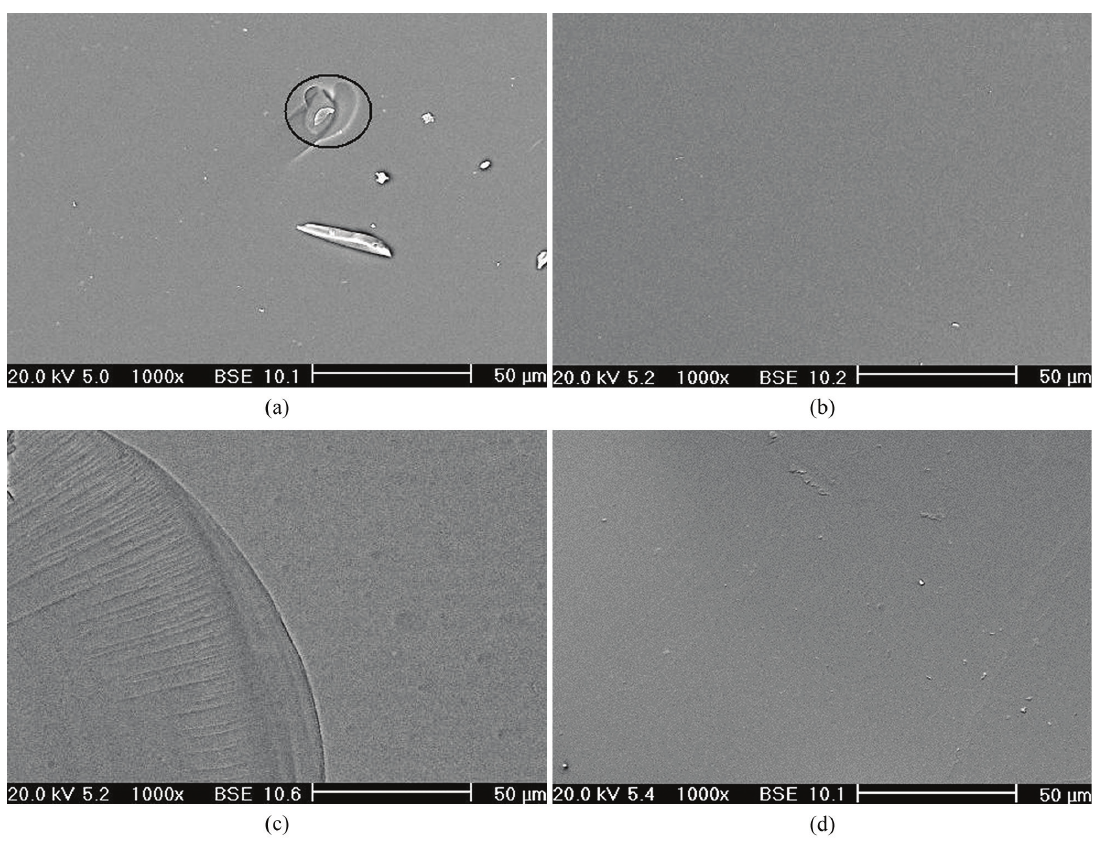
Figure 3. SEM images of rock wools fabricated using only granite waste (a), only steelmaking slag (b), both residues (c), and from a industrial sample